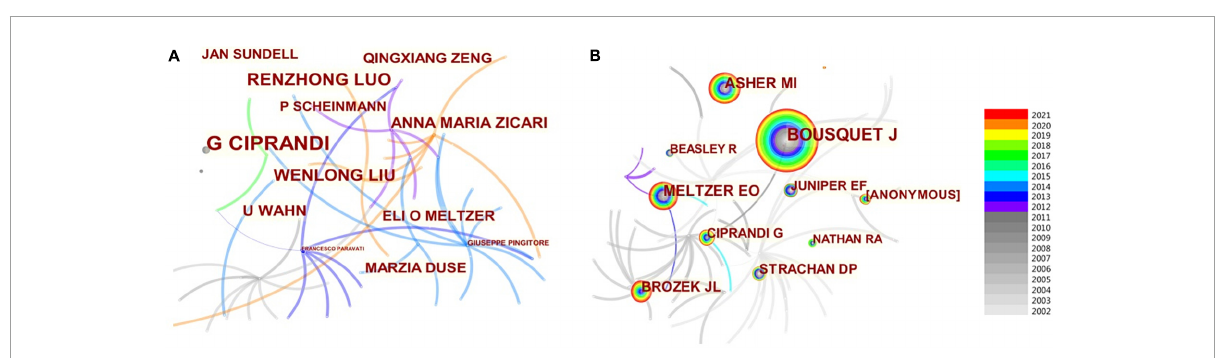
FIGURE3 Relevant map of authors on AR research in children. (A) Author map. (B) Co-cited author